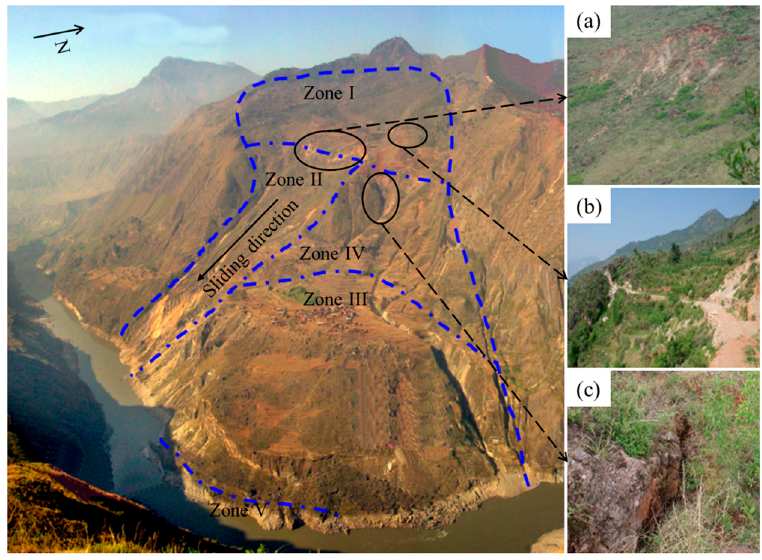
Figure 3. Local features of the Jinpingzi landslide. ( a ) The main deformation of Zone II; ( b ) The small-scale slump of the steep slope at the rear edge of the landslide; ( c ) A large crack forming with movement.